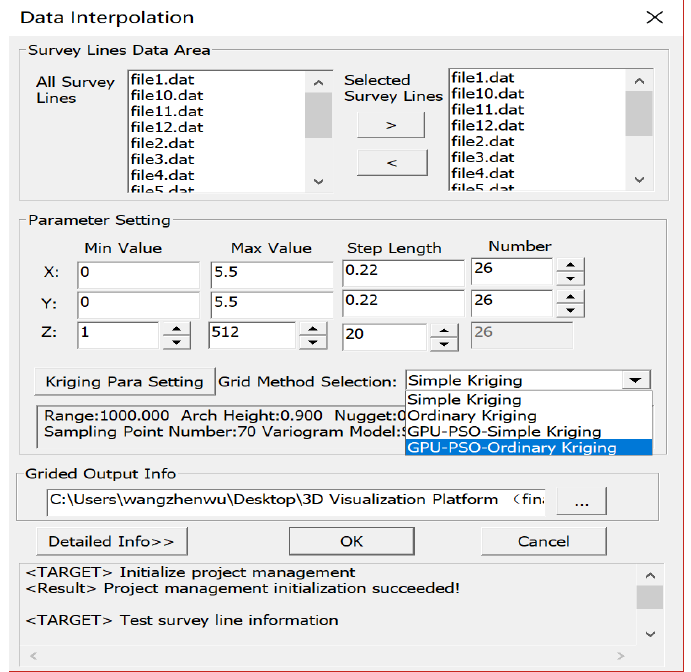
Figure 7. Survey line data visualization.